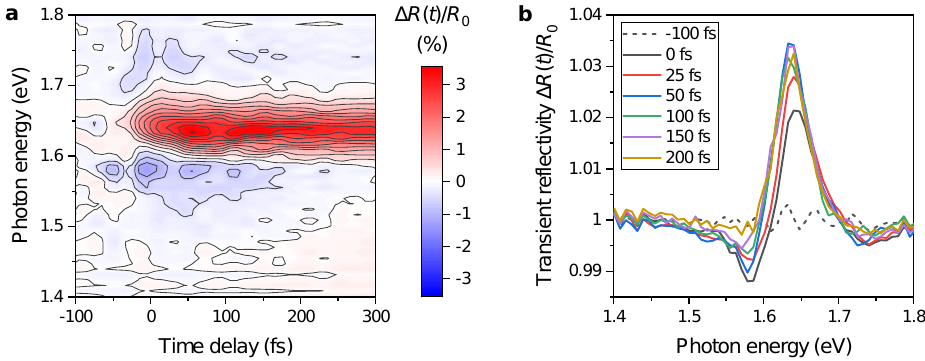
Figure 5. ( a ) Ultrafast dynamics of transient reflectivity of WSe 2 monolayer measured with linearly polarized pump and probe pulses with crossed polarizations. ( b ) Transient reflectivity spectra in different time delays between the pump and probe